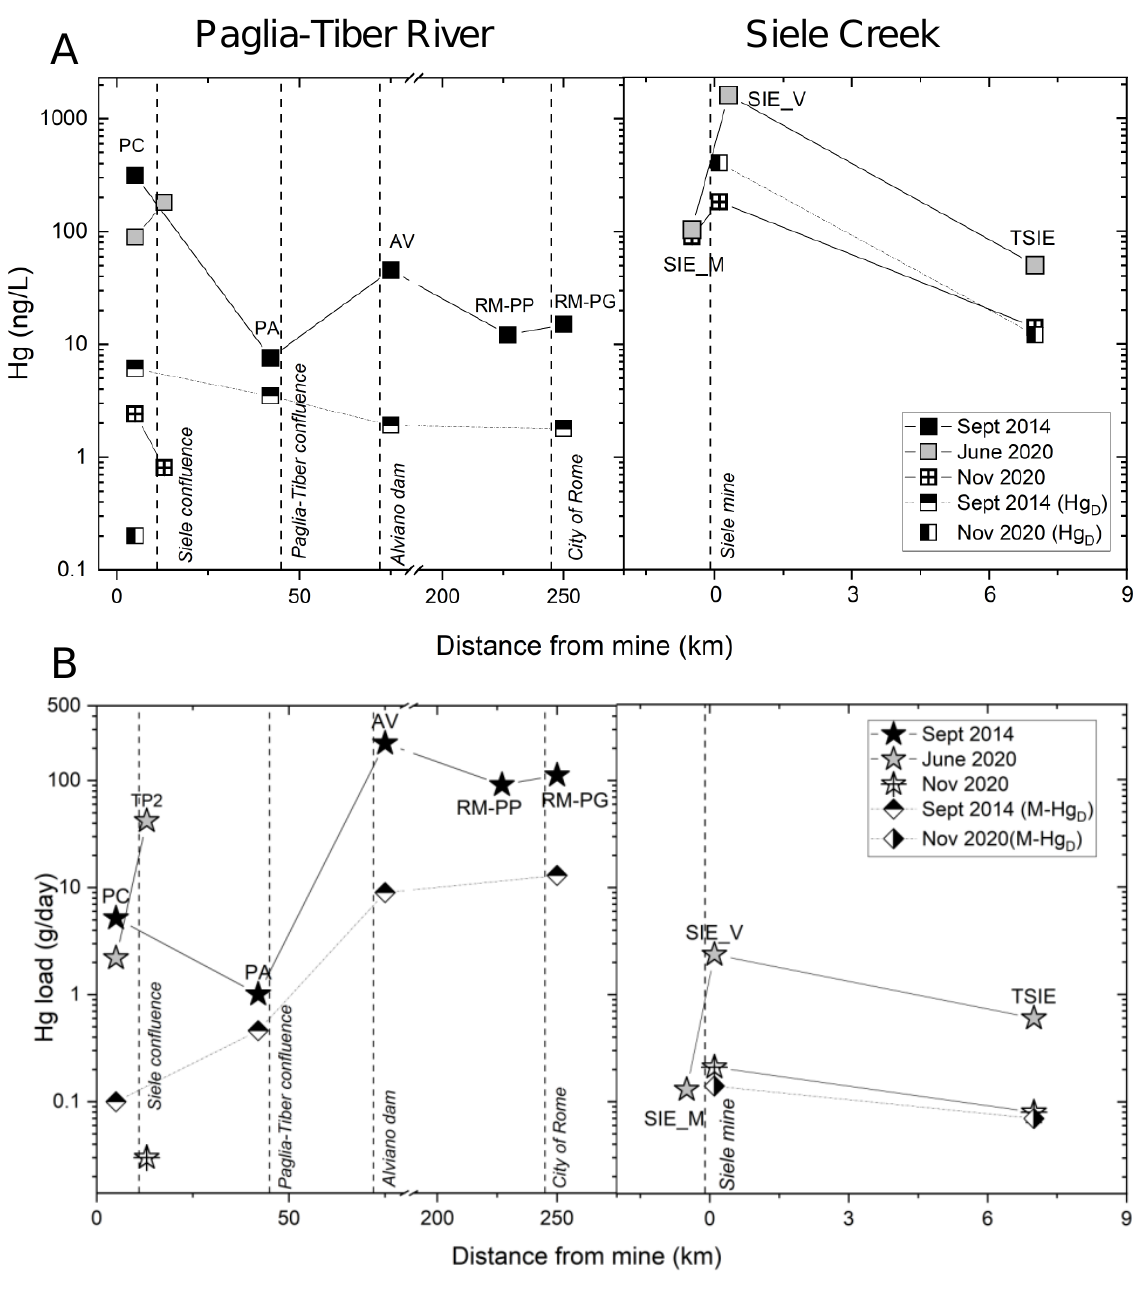
Figure 2. Variation in ( A ) Hgt concentrations (ng L − 1 ) and ( B ) Hg mass loads (M-Hg) (g day − 1 ) in the Paglia–Tiber River system and Siele Creek with distance from mine (km).